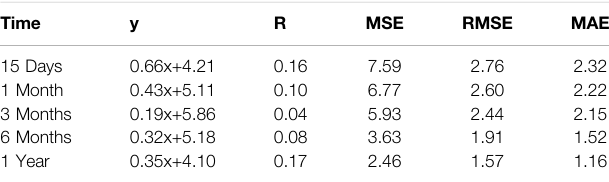
TABLE 3 | SO 2 2020 model performance statistics with different time period in Jiangsu Province. Time